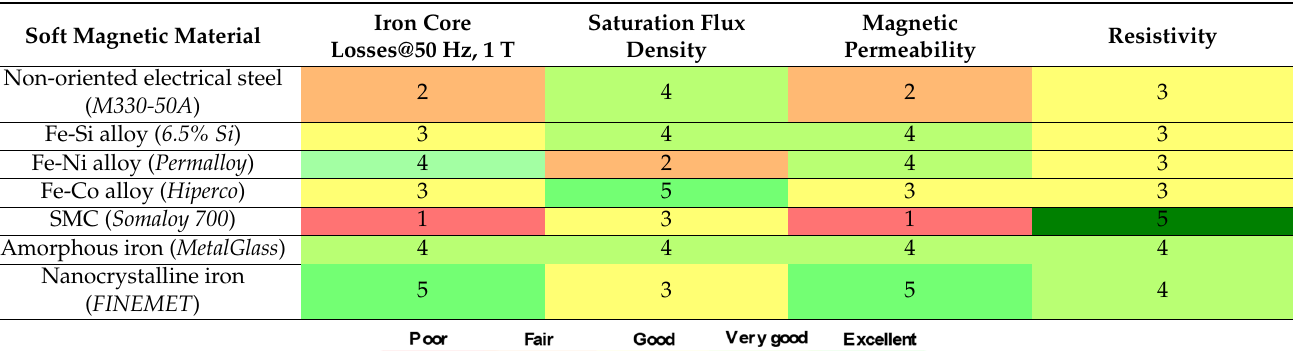
Table 1. Comparison of soft magnetic materials to be used for iron cores processed by AM.